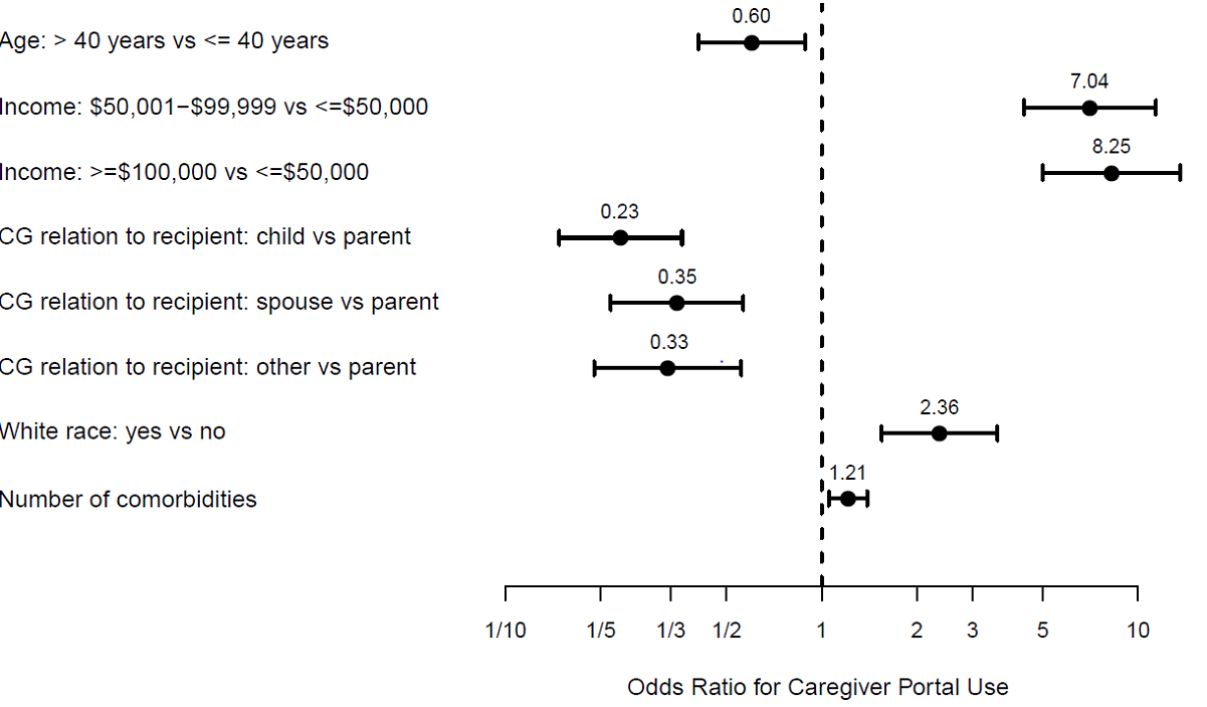
Figure 6. Multivariate odds ratios (dots) and 95% confidence intervals (bars) for combined caregiver characteristics and mental health for the use of a caregiver’s own health